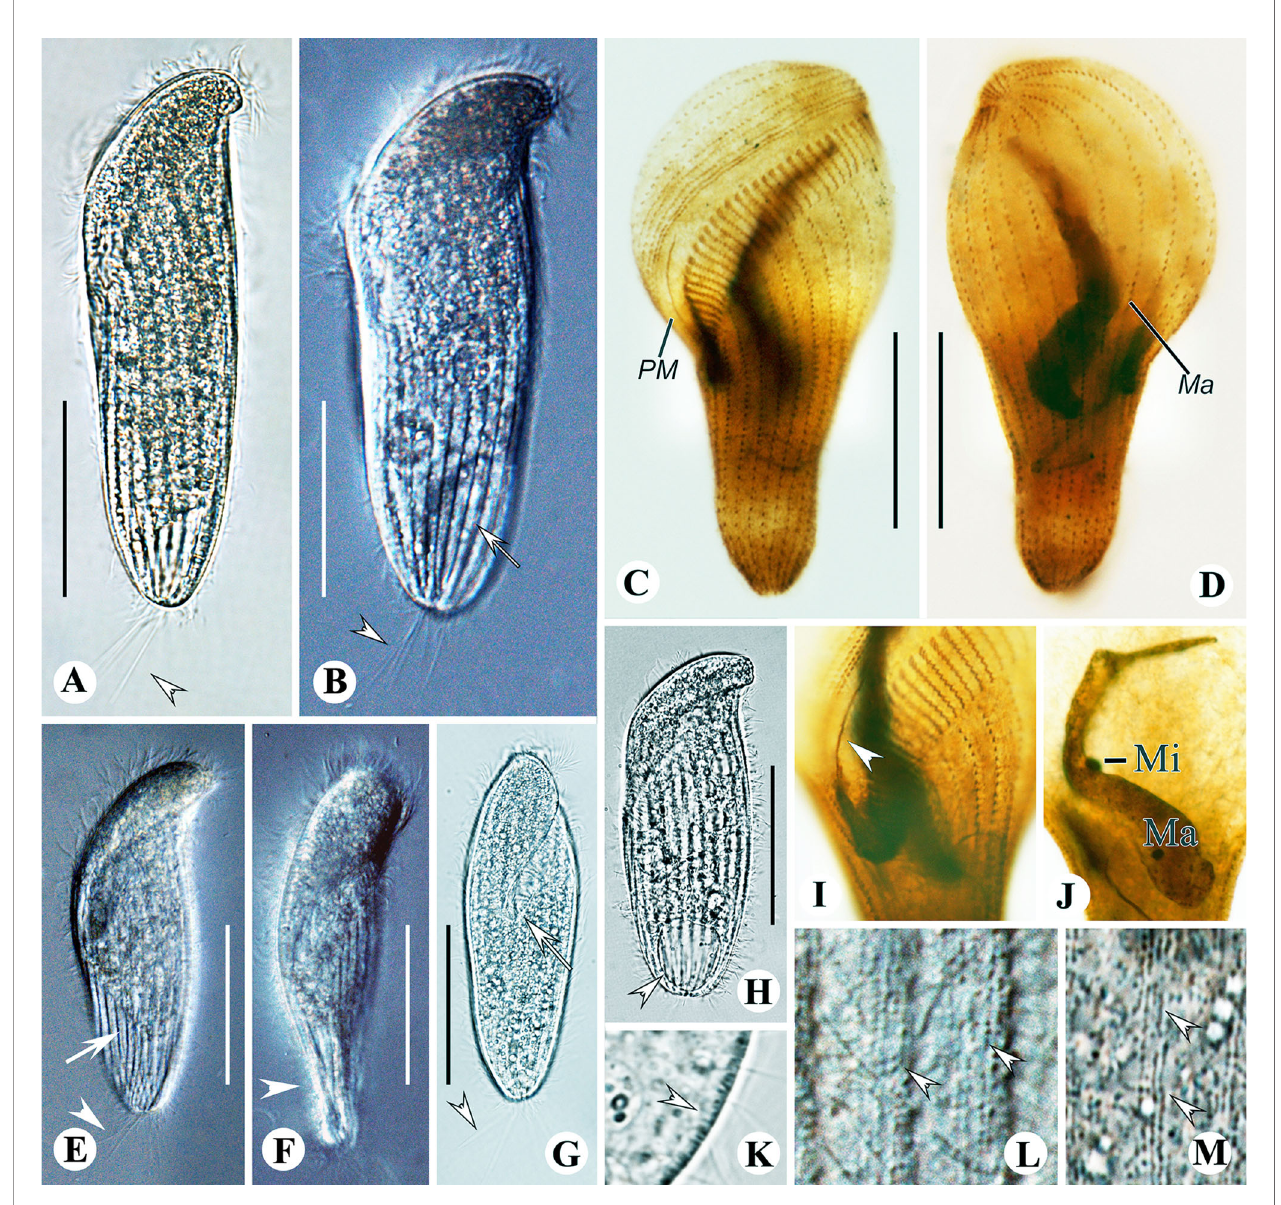
FIGURE 3 | Metopus paraes sp. n. from life with bright- fi eld (A, G, H, K, M) , and differential interference contrast (B, E, F, L) illuminations, and after protargol staining (C, D, I, J) . (A, B, E) Ventral view showing body shape and caudal cilia (arrowheads) and kinetal furrows (arrows). (C, D) Ventral (C) and dorsal (D) view of the holotype showing ciliature and macronucleus. (F) Right ventral view showing dorsal-ventrally fl attened posterior body (arrowhead). (G) Right ventral view showing caudal cilia (arrowhead) and the proximal end of the adoral zone (arrow). (H) Ventral view showing contractile vacuole (arrowhead). (I) Paroral membrane (arrowhead). (J) Macronucleus and micronucleus. (K) Lateral view showing cortical granules (arrowhead). (L) Arrangement of cortical granules (arrowheads). (M) Arrangement and color of cortical granules (arrowheads). Ma, macronucleus; Mi, micronucleus; PM, paroral membrane. Scale bars: 40 m